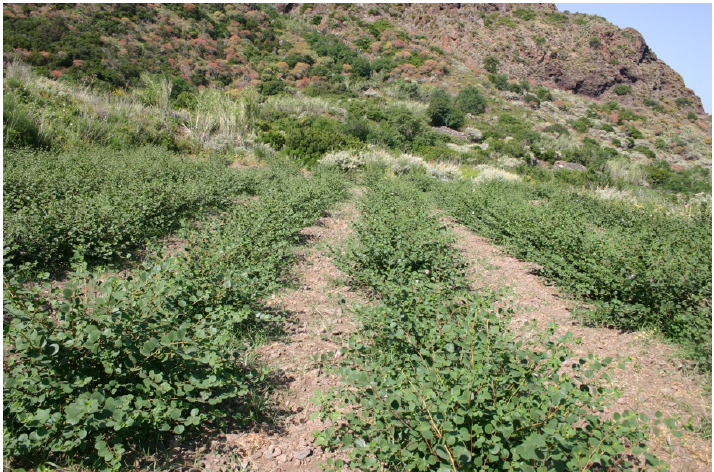
Figure 2. Intensive caper orchard on the island of Salina .